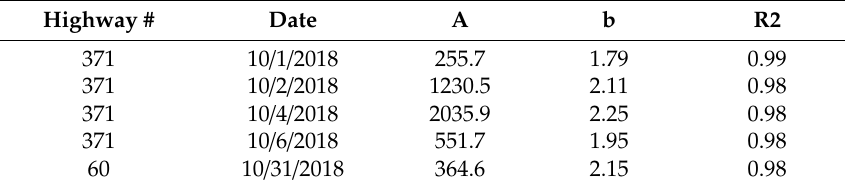
Table 2. Asphalt specimen conventional model-generated dielectric to air void prediction coe ffi cients and goodness of fit.